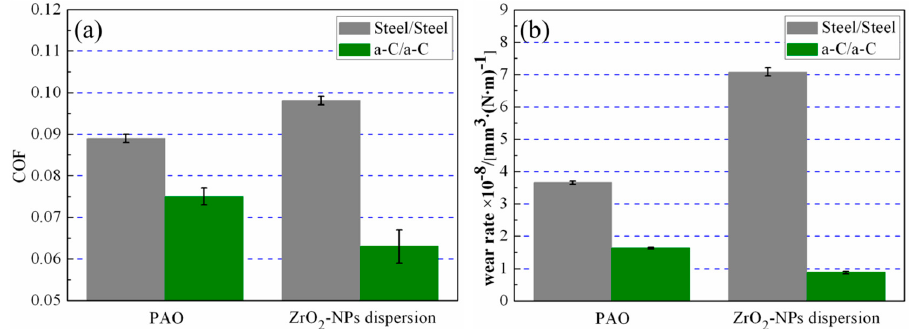
Figure 2. ( a ) The average COFs; and ( b ) wear rates of steel/steel and a-C/a-C contacts under the lubrication of pure PAO and ZrO 2 -NPs dispersion.